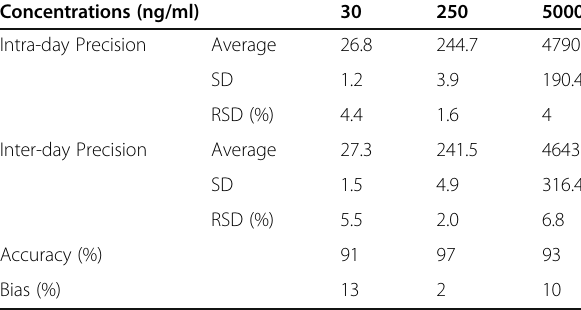
Table 2 Validation data for bias, precision, and